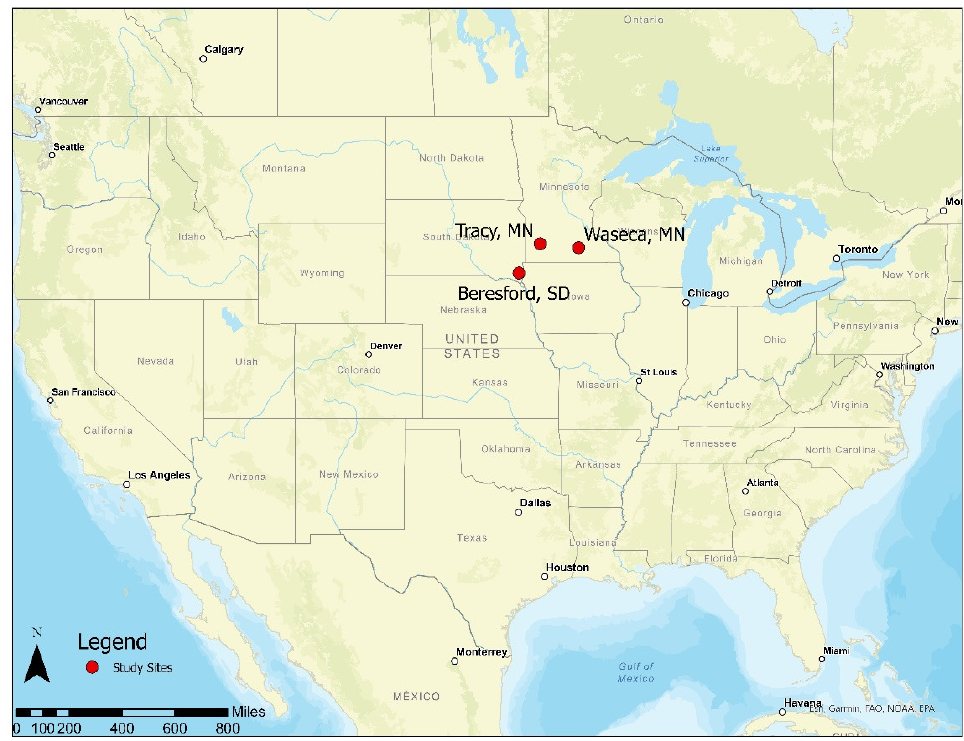
Figure 1. Study sites: Beresford, SD (43.048568°, −96.894815°); Tracy, MN (44.347556°, −95.543803°); Waseca, MN (44.060210°, −93.546401°).